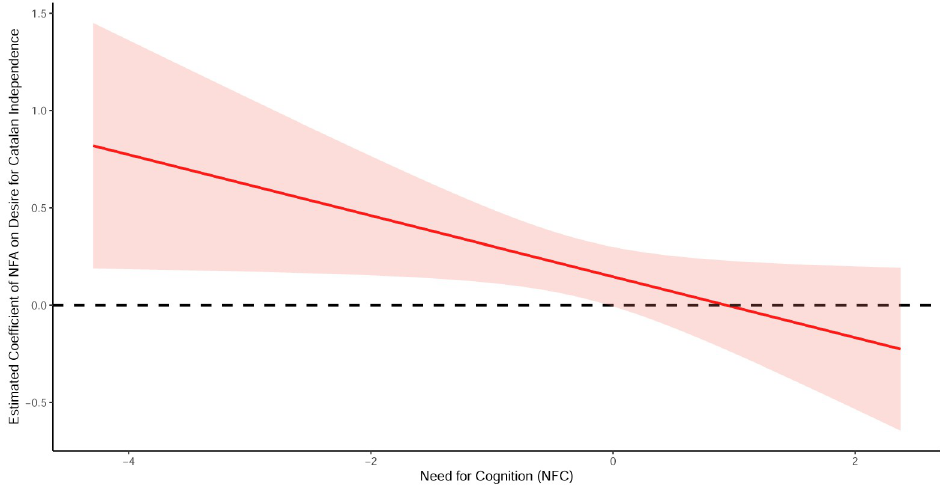
Fig 3. Marginal effects of NFA on the desire for independence conditional on NFC (Interaction-effect models).